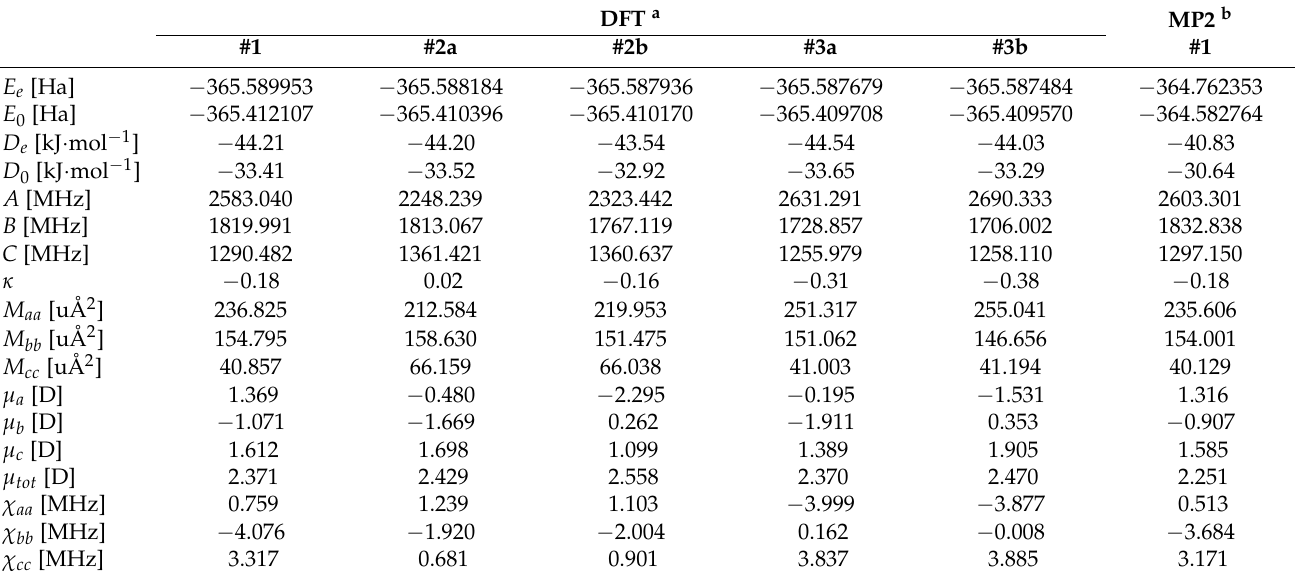
Table 1. Theoretical energy values and spectroscopic parameters of DEHA-W conformers. DFT